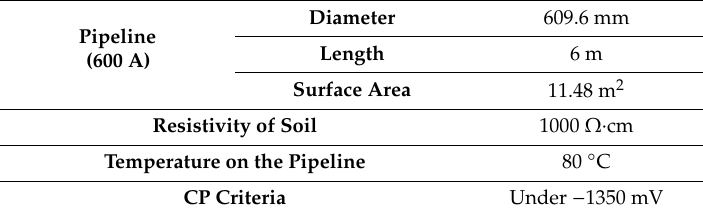
Table 6. Required current calculation for cathodic protection (CP).